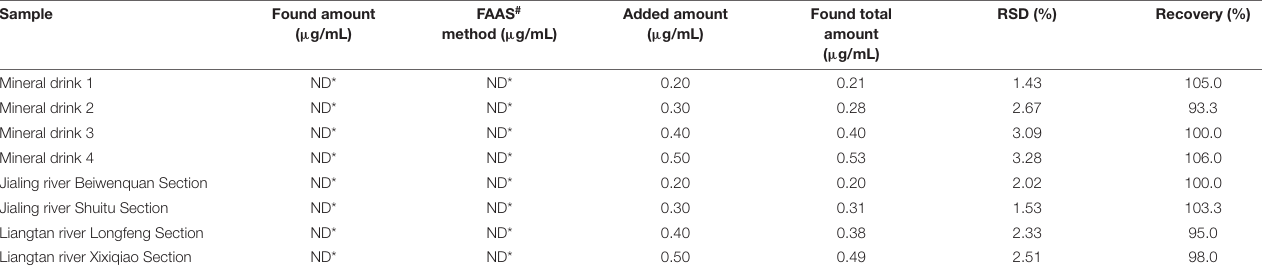
TABLE 4 | Results for the determination of Ag(I) in mineral drinks and environment water